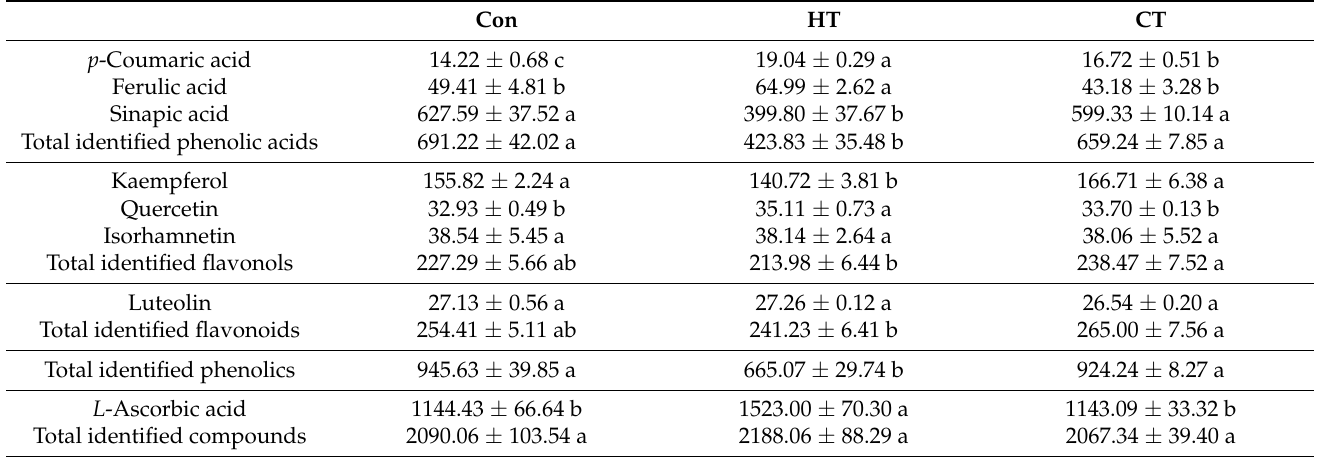
Table 3. Effects of hot- and cold-water stress on the concentration of individual phenolic compounds and vitamin C in broccoli. The results are expressed in µ g/g of dry